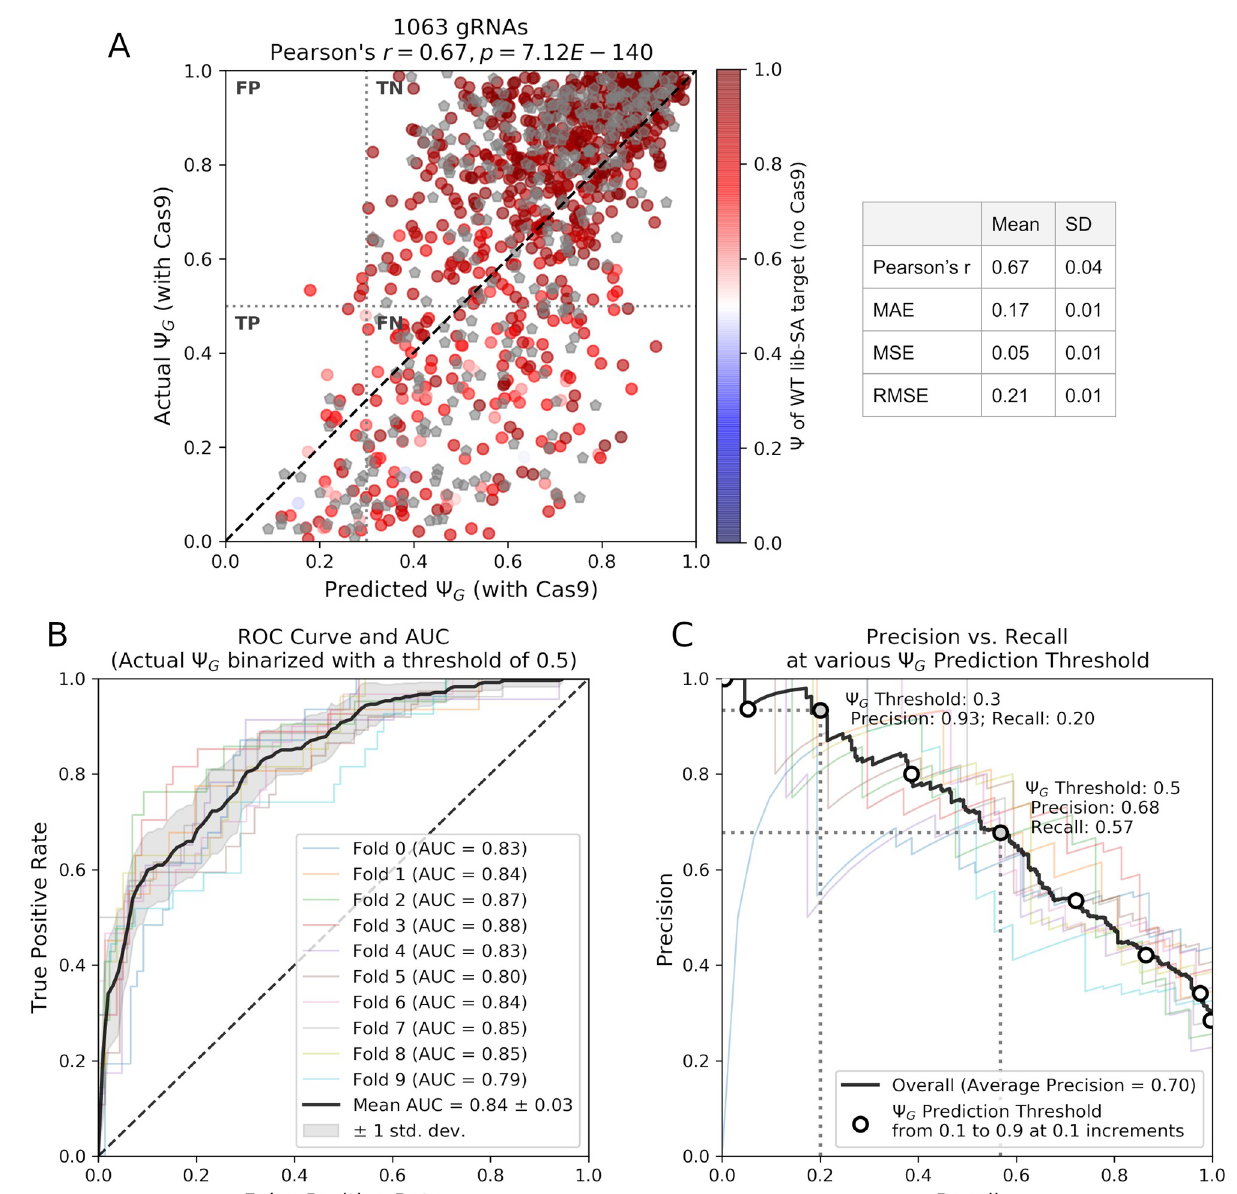
Fig 4. Performance of SkipGuide in identifying effective Sp Cas9 gRNAs. (A) Plot of the actual C vs. the 10-fold cross validated predictions of C G G from SkipGuide on 1,063 gRNAs ( r = 0.67). Various regression metrics averaged over the 10 folds are shown (MAE denotes mean absolute error, MSE denotes mean squared error, RMSE denotes root-mean-square error, and SD denotes standard deviation). Each point is either colored by the corresponding WT C before Cas9 treatment (735 total), or is labeled with a gray pentagon if the corresponding WT C is unknown. Regions of true positives (TP), false positives (FP), true negatives (TN), and false negatives (FN) are shown when the actual C is binarized with a threshold of 0.5, and G the predicted C is binarized with a threshold of 0.3. (B) Receiver operating characteristic (ROC) curves across the 10 folds, using a 0.5 binary threshold G for the actual C G (mean AUC = 0.84). (C) A plot of precision vs recall (of both overall and each of the 10 folds, assuming the threshold for the actual C G is 0.5) at various choices of predicted C binarization threshold. Choosing a prediction threshold of 0.5 gives a precision of 0.68, and choosing a lower G threshold of 0.3 gives a higher precision of